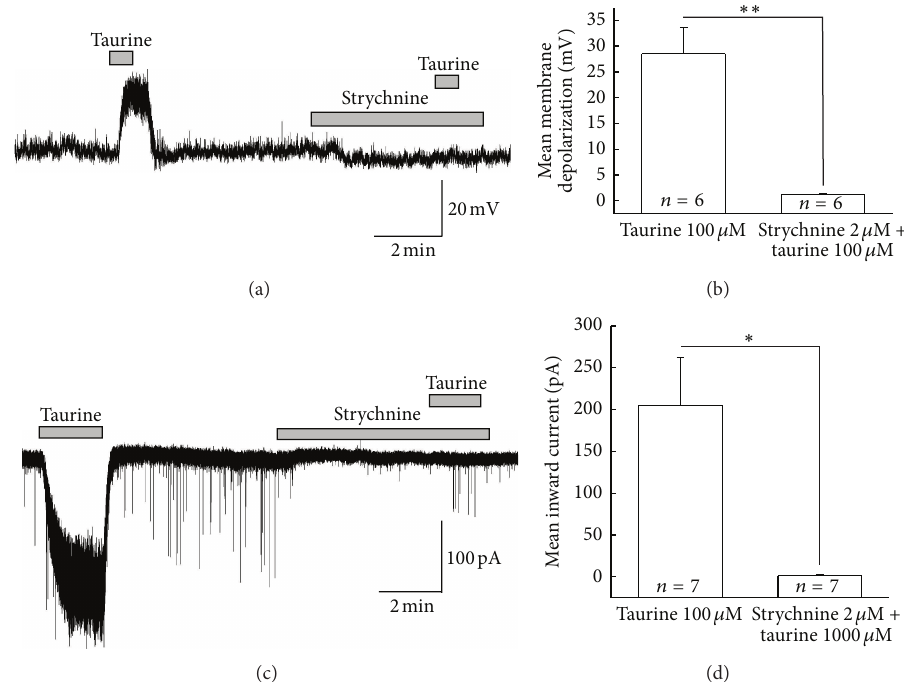
Figure 4: Inhibition of taurine-induced membrane depolarization and inward current by strychnine on SG neurons of Vc. (a), (c) Representativetracesshowingthetaurine-inducedmembranedepolarizationandtaurine-inducedinwardcurrentwereblockedbystrychnine (2 𝜇 M), a glycine receptor (GlyR) antagonist. (b), (d) Bar graphs showing the comparisons of mean relative membrane potential and inward current changed by the taurine alone and in the presence of strychnine ( ∗ 𝑃 < 0.05 , ∗∗ 𝑃 < 0.01